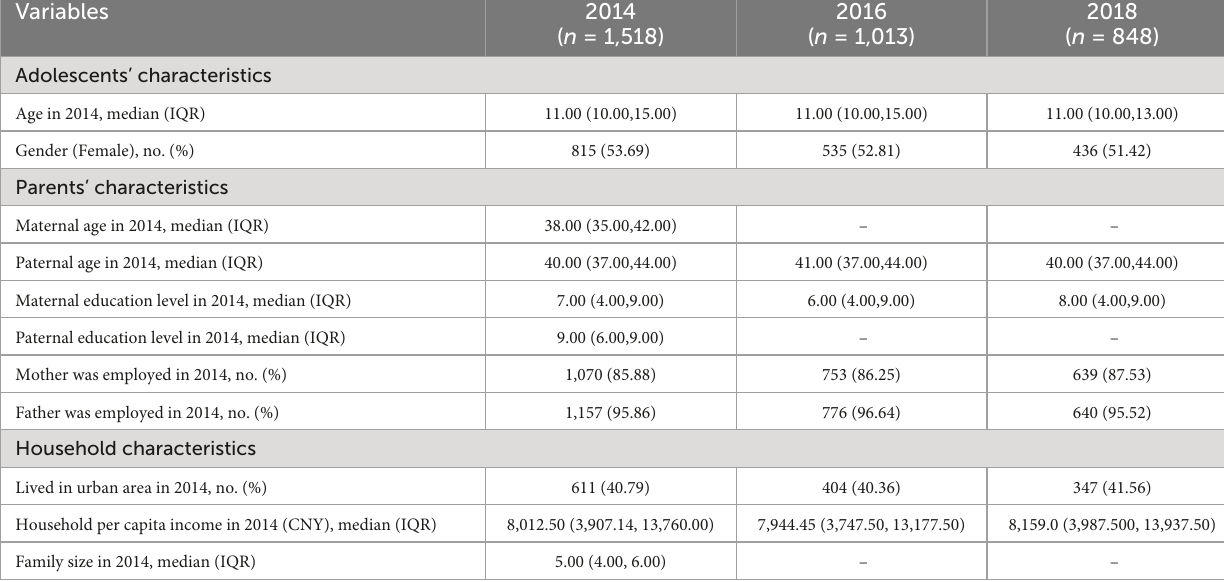
TABLE 1 The demographic characteristics of the study population by the year.